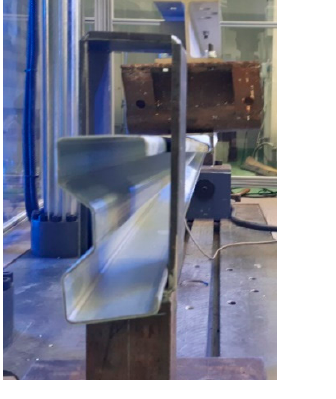
Figure 4. Details of the laboratory stand: ( a ) beam support detail; ( b ) of the load application through the hot-rolled C100